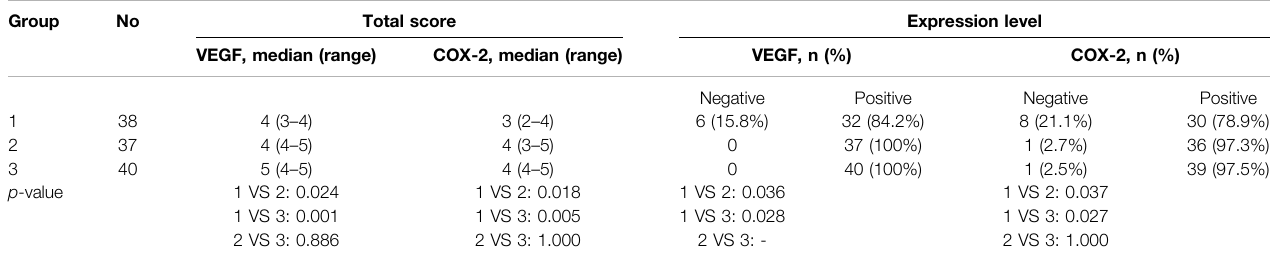
VEGF: vascular endothelial growth factor; COX: